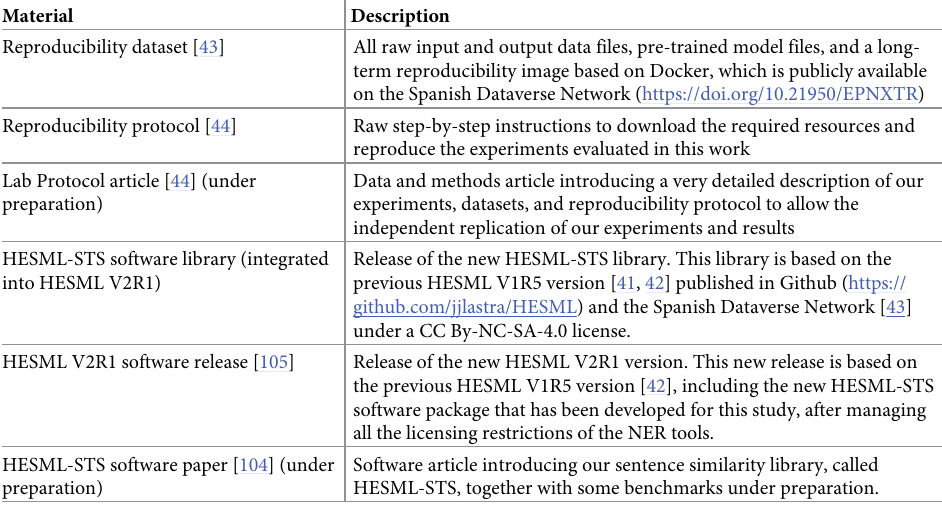
Table 6. Supplementary material and reproducibility resources of this